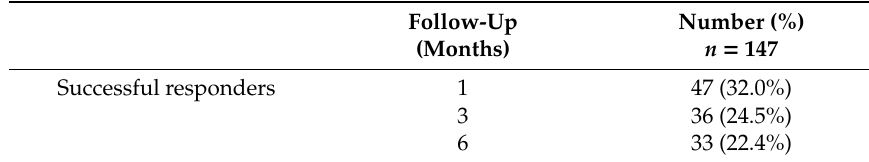
Table 2. Proportion of responders to treatment after combined epidural adhesiolysis and balloon decompression in patients with lumbar post-laminectomy